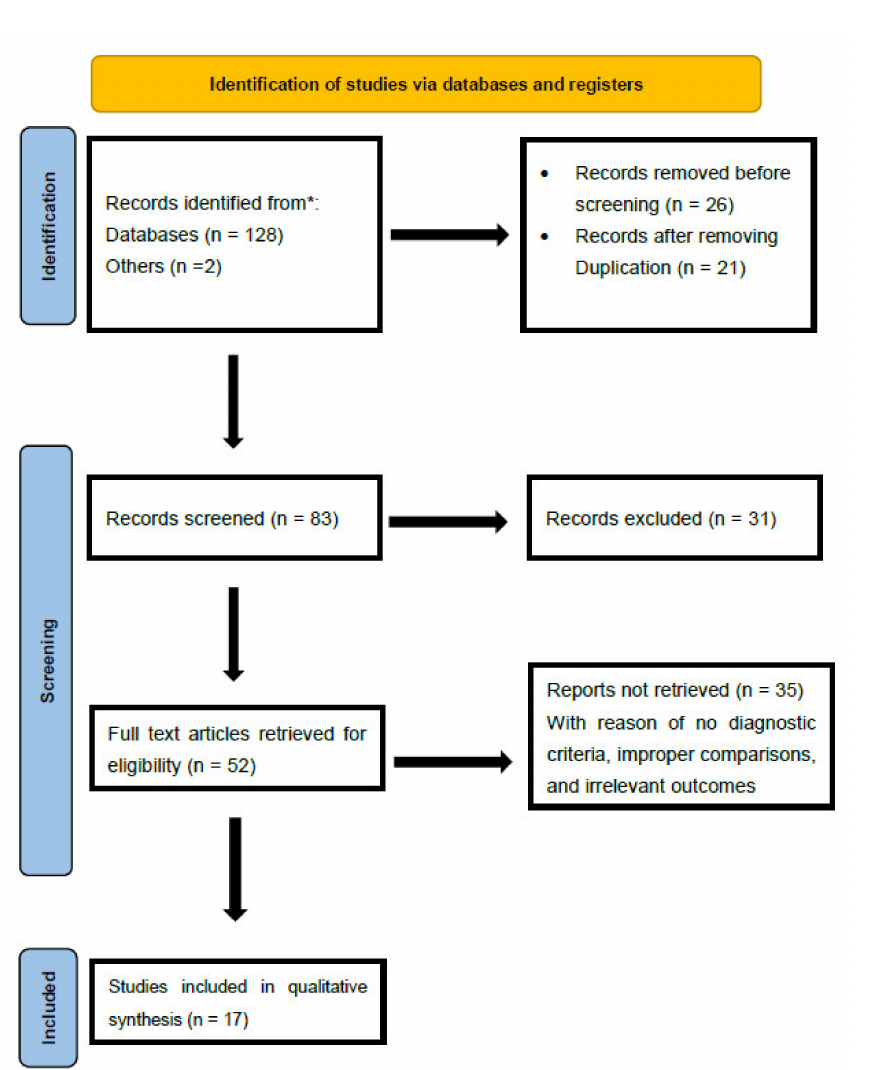
Figure 1. Flow diagram showing the review process and study synthesis. * Flow diagram showing the review process and study synthesis.